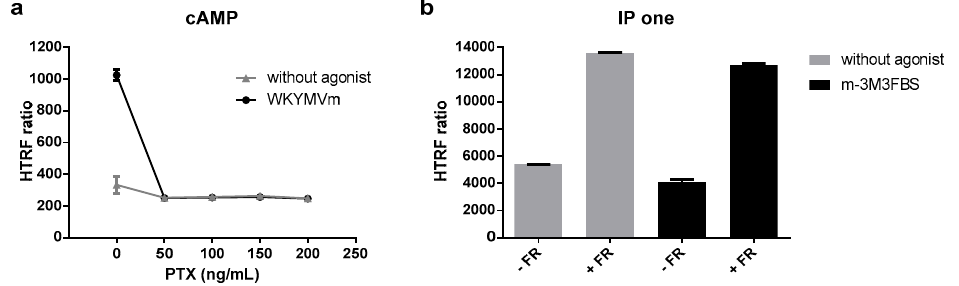
Figure A4. Analysis of G protein dependency. ( a ) PTX-mediated inhibition of FPR1-mediated changes in cAMP generation. ( a ) Maximum FPR1-mediated inhibition of forskolin-induced cAMP formation was completely prevented in cells pretreated for 16 h with 100 ng / mL PTX. ( b ) E ff ect of 1 µ M FR preincubation for 1 h on IP-1 production induced by the phospholipase C activator m-3M3FBS. Data points represent the mean ± SEM.